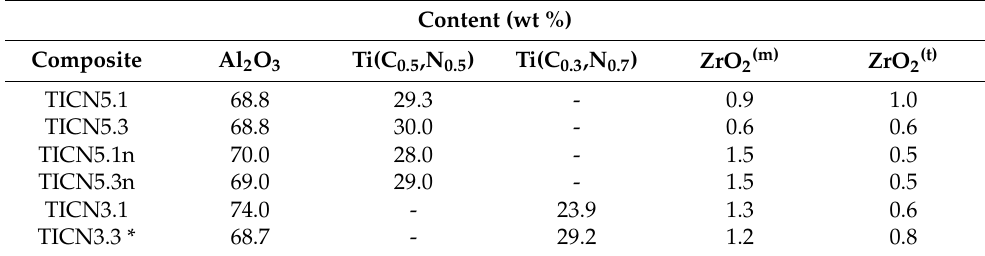
Table 4. X-ray diffraction analysis of the tested composites sintered using